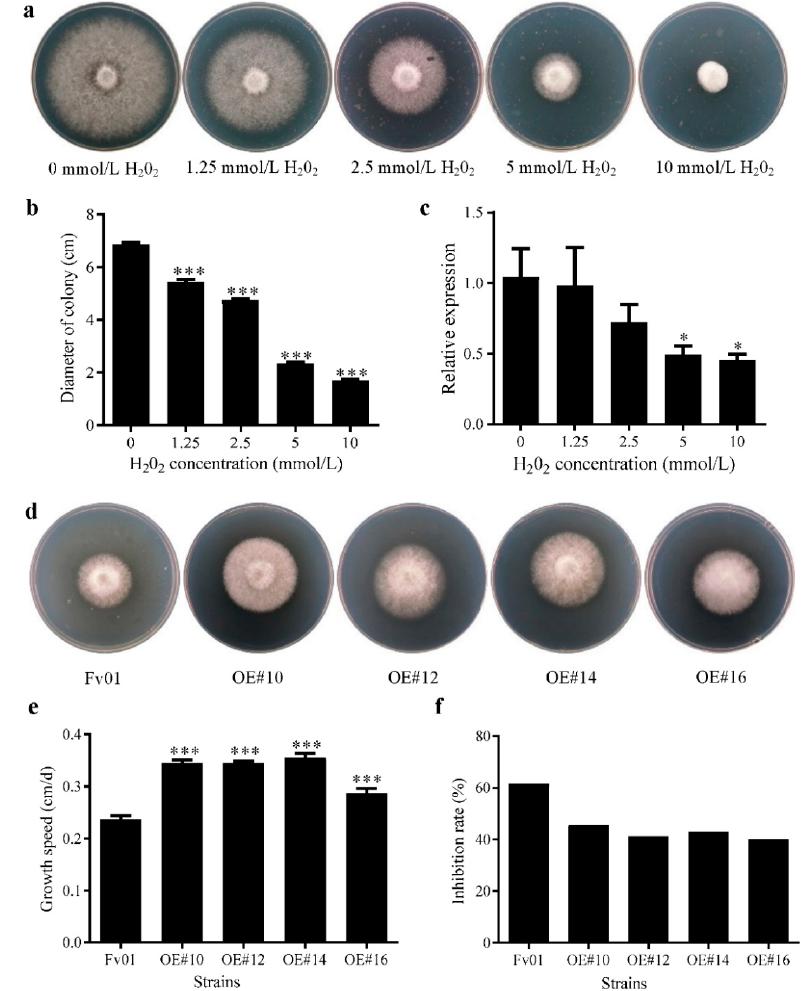
Figure 5. The expression of F. filiformis FfGS6 in response to H 2 O 2 stress and the growth inhibition rate of H 2 O 2 on the overexpression transformants. ( a ) The growth phenotype of wild-type strain Fv01 was cultured in a medium containing different concentrations (0, 1.25, 2.5, 5, and 10 mmol/L) of H 2 O 2 . ( b ) The diameters of colonies after wild-type strain Fv01 was cultured in the medium containing different concentrations (0, 1.25, 2.5, 5, and 10 mmol/L) of H 2 O 2 . ( c ) FfGS6 gene expression after wild- type strain Fv01 was cultured in the medium containing different concentrations (0, 1.25, 2.5, 5, and 10 mmol/L) of H 2 O 2 . ( d ) Phenotypic observation of Fv01 and FfGS6 overexpression transformants cultured on 5 mmol/L H 2 O 2 PDA plate. ( e ) Mycelial growth rates of Fv01 and FfGS6 overexpression transformants cultured in 5 mmol/L H 2 O 2 PDA plates. ( f ) Growth inhibition rates of Fv01 and FfGS6 overexpression transformants on 5 mmol/L H 2 O 2 PDA plates. Asterisks represent the significant differences versus 0 mol/L H 2 O 2 ( t -test, n = 3; *, p < 0.05; ***, p < 0.001) and